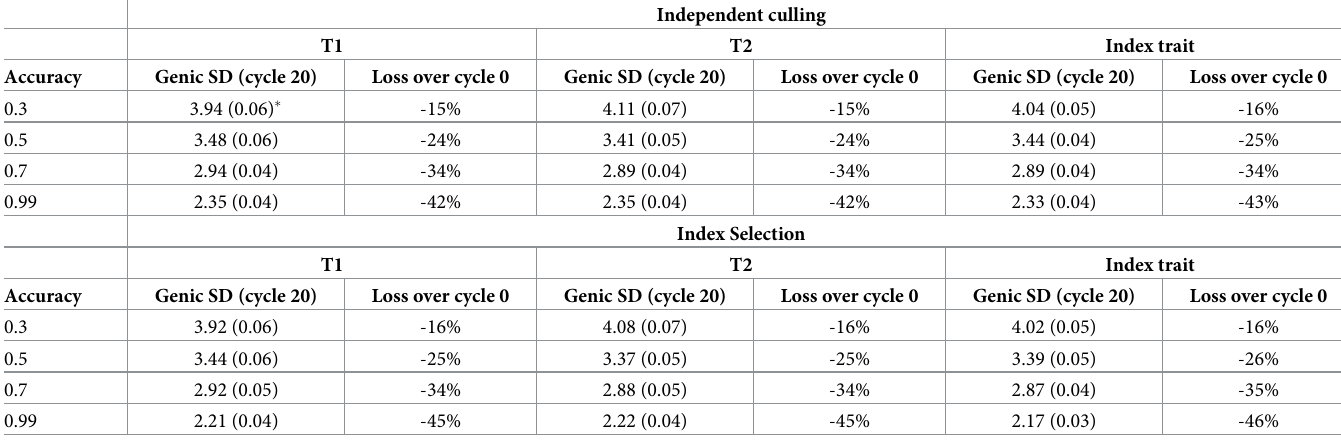
Table 3. Genic standard deviation (Genic SD) of parents in cycle 20 and loss in genic standard deviation in cycle 20 in comparison to the genic standard deviation in cycle 0 (Loss over cycle 0) for trait 1 (T1), trait 2 (T2) and the index trait using either optimal independent culling or index selection with different levels of accu- racy, unfavourably correlated traits, and T2 relative economic importance of